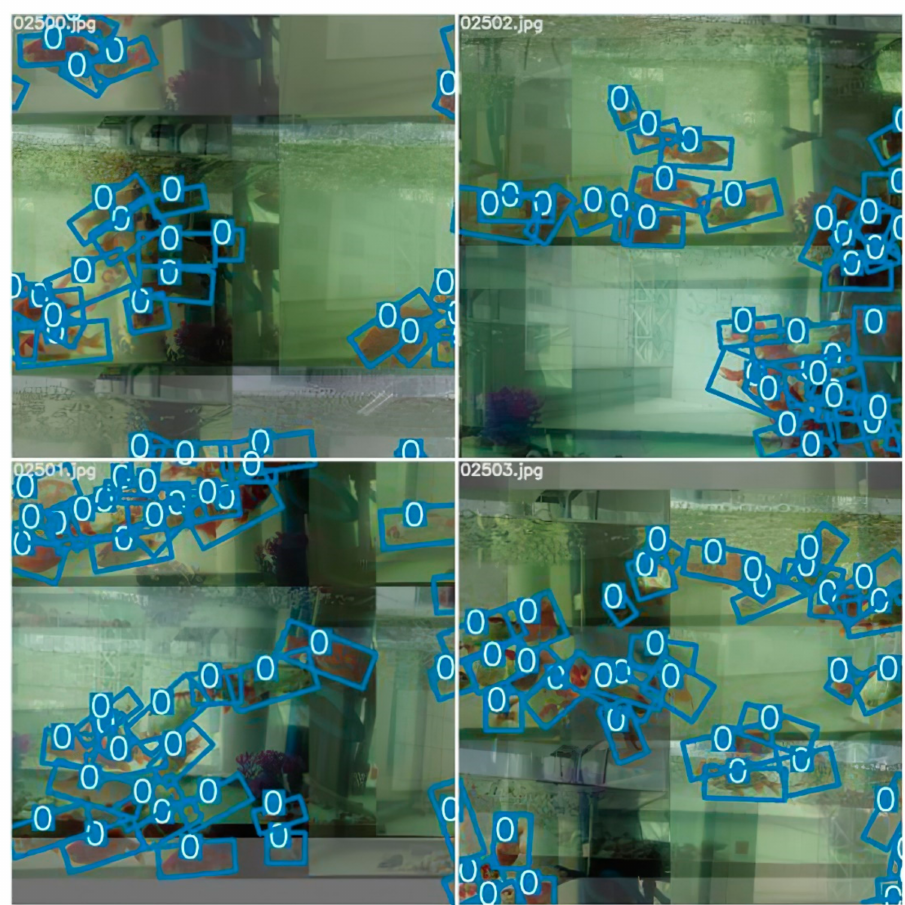
Figure 5. Training images after mosaic and mixup